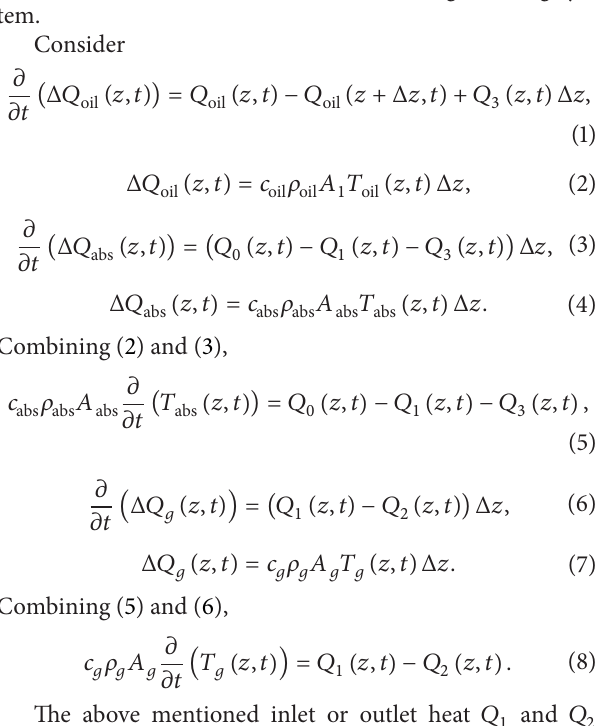
Figure 2: Schematic diagram of the heat transfer analysis [1–3, 8].